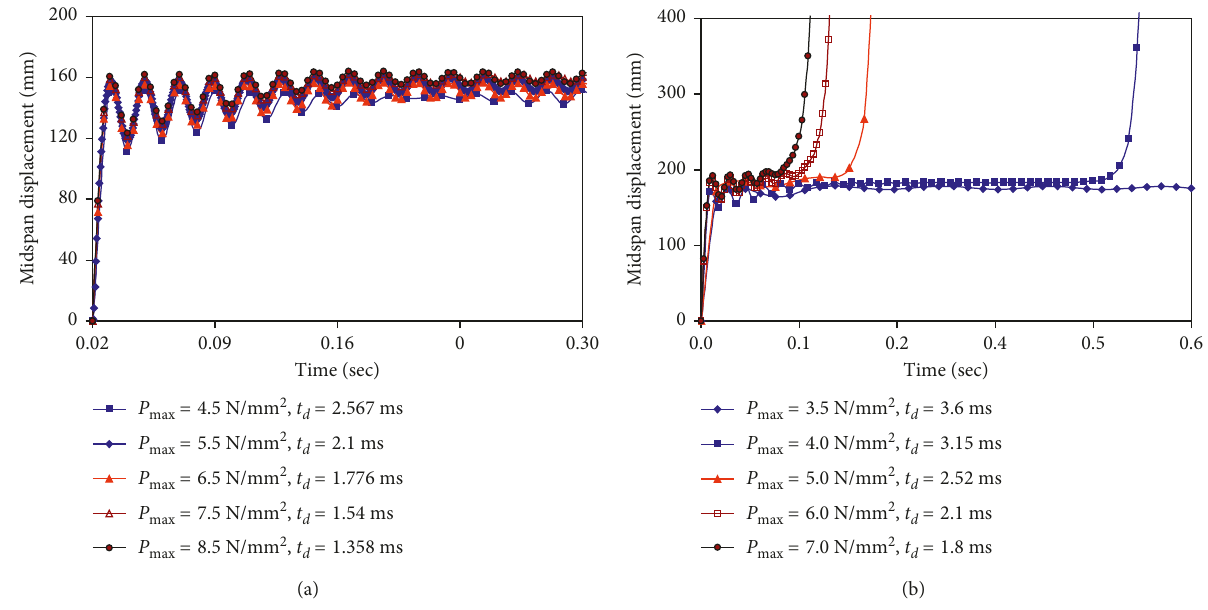
Figure 9: Midspan lateral displacement time histories of the steel column W150 different combinations of blast